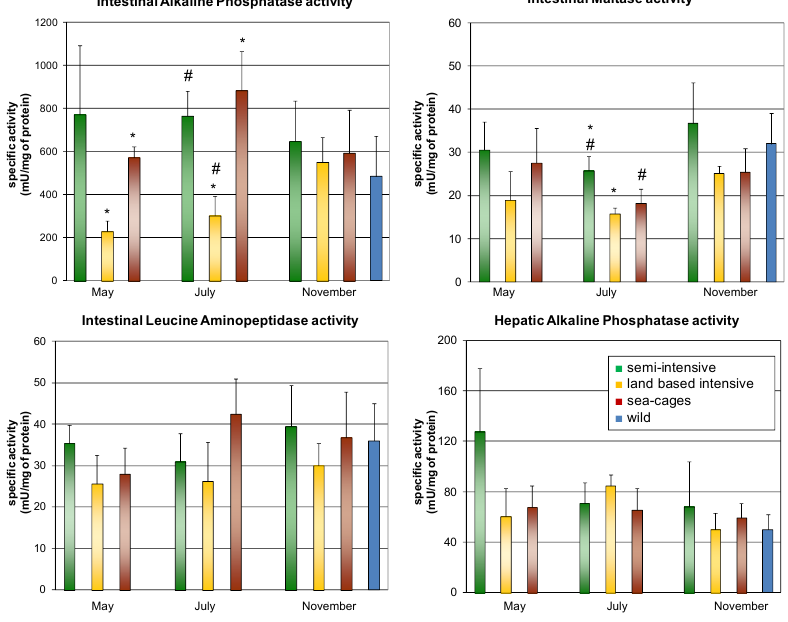
Figure 1. Top left, intestinal alkaline phosphatase activity; bottom, left intestinal leucine aminopeptidase activity; top right, intestinal maltase activity; bottom right hepatic phosphatase activity. Data for wild specimens, used as control, are shown only for the last month of the trial period. Each value represents mean ± SD of 3 replicates. Pairs of significantly different mean values (based on a t-test for independent samples, p-values < 0.05) are label with the same symbol. Homogeneity of variances is always satisfied at a p-value of